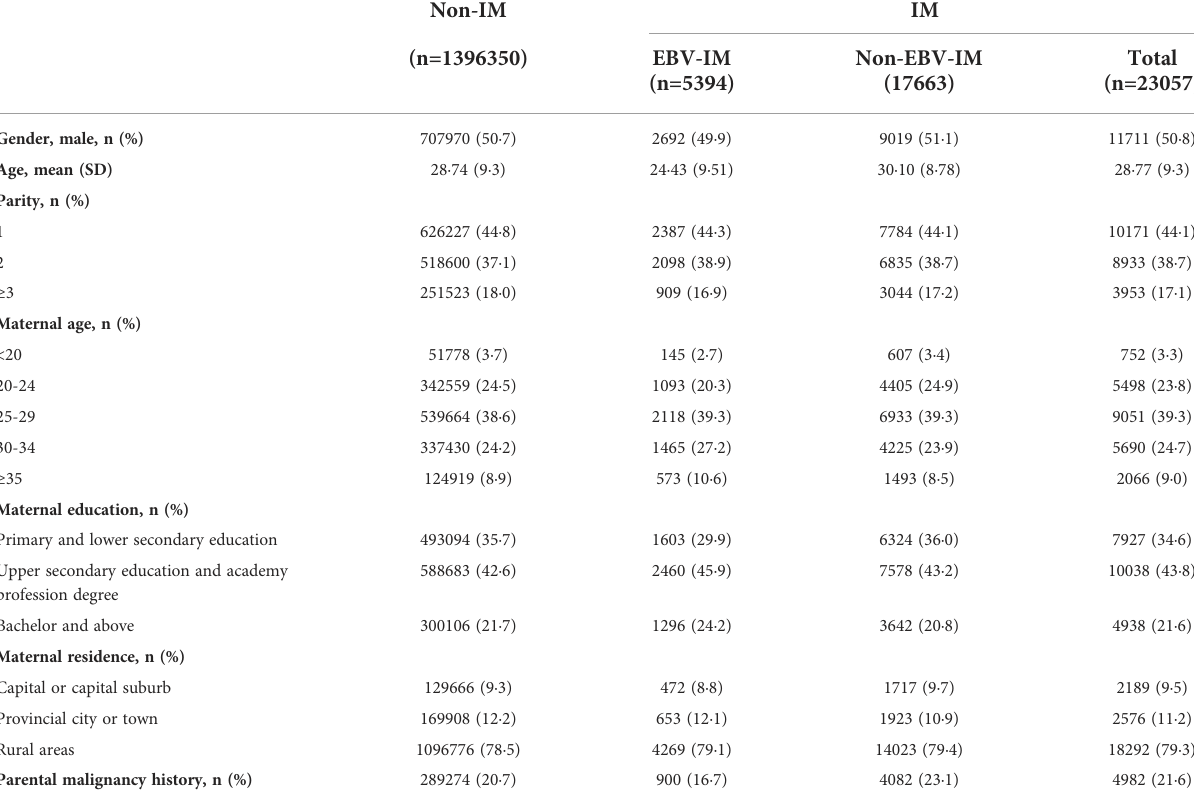
TABLE 1 Basic characteristics of population with or without Infectious Mononucleosis